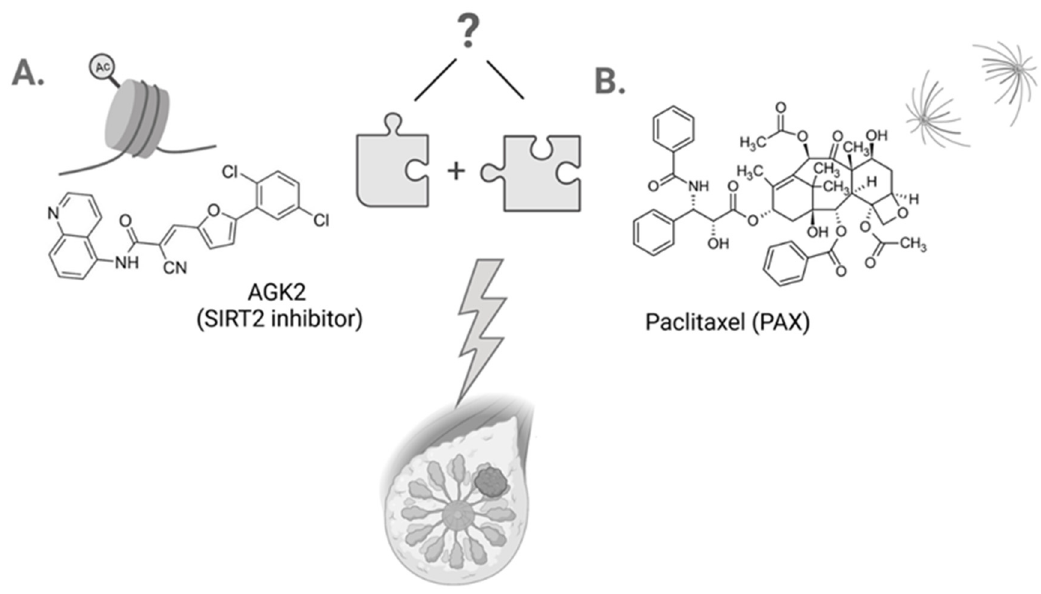
Figure 1. Chemical structures of AGK2 (SIRT2 inhibitor) (C 23 H 13 Cl 2 N 3 O 2 ) ( A ) and paclitaxel (PAX) (C 47 H 51 NO 14 ) ( B ). Created with www.biorender.com (accessed on 31 March 2022).